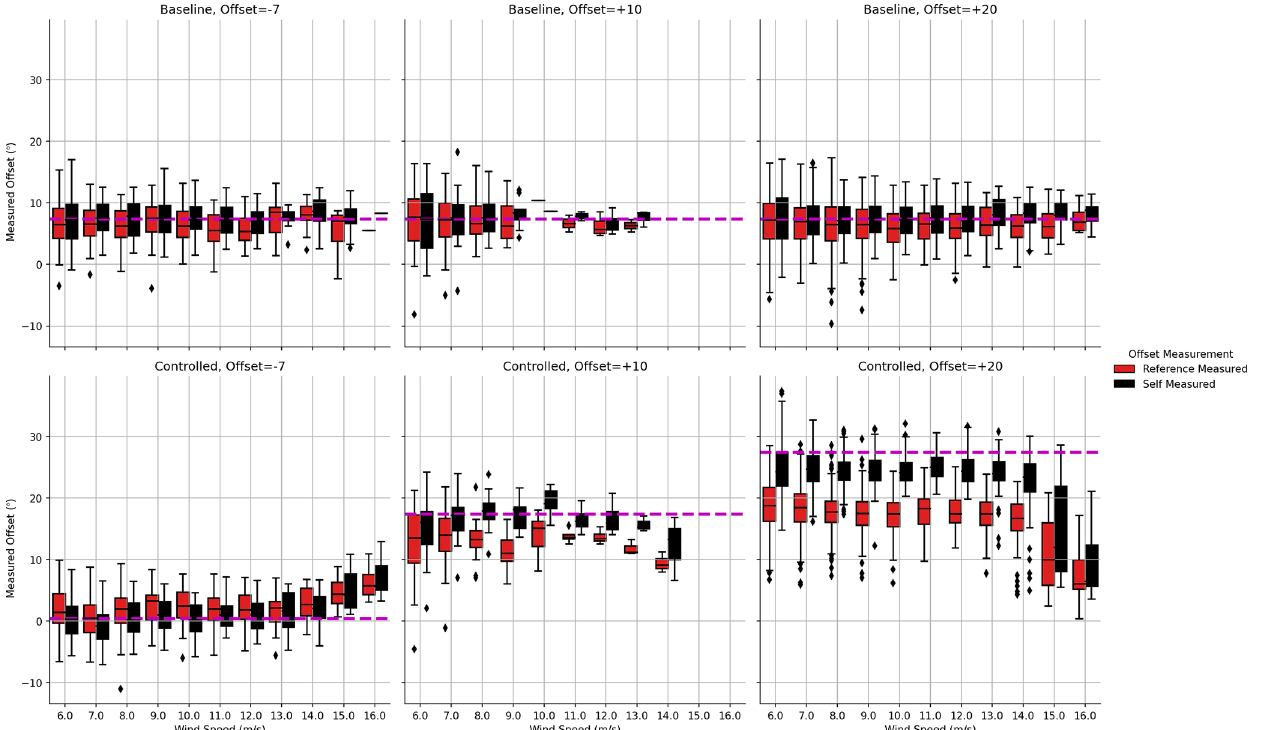
Figure 4. Boxplots, binned by wind speed, of the offset of the controlled wind turbine (turbine 5), as measured by its own vane (black) or in comparison to a reference wind direction (red). The targeted offset is indicated in each case with a magenta dashed line.